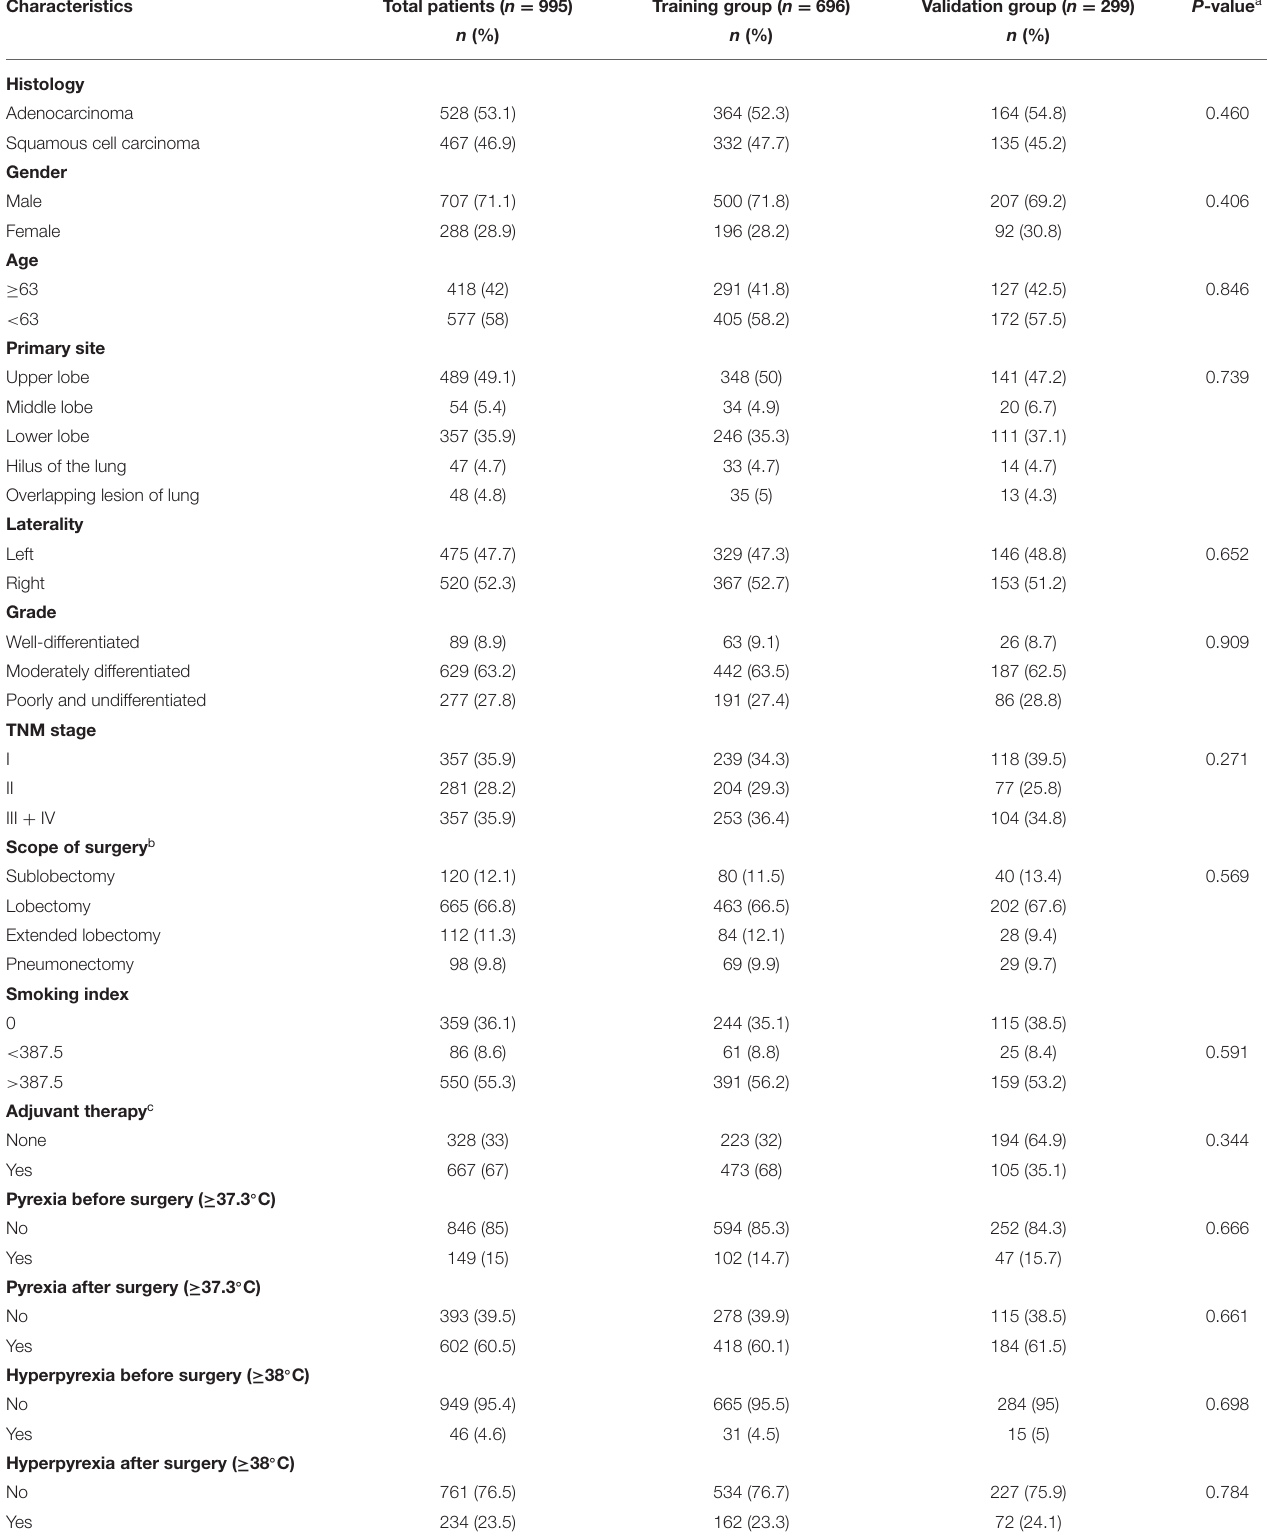
TABLE 1 | The baseline information of population in total patients, training group, and validation group.